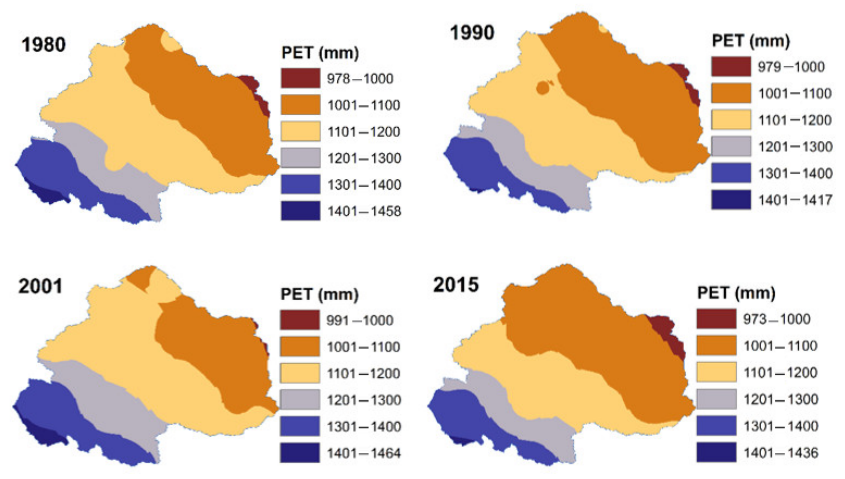
Figure 9. Spatial distribution of PET obtained from CRU datasets.